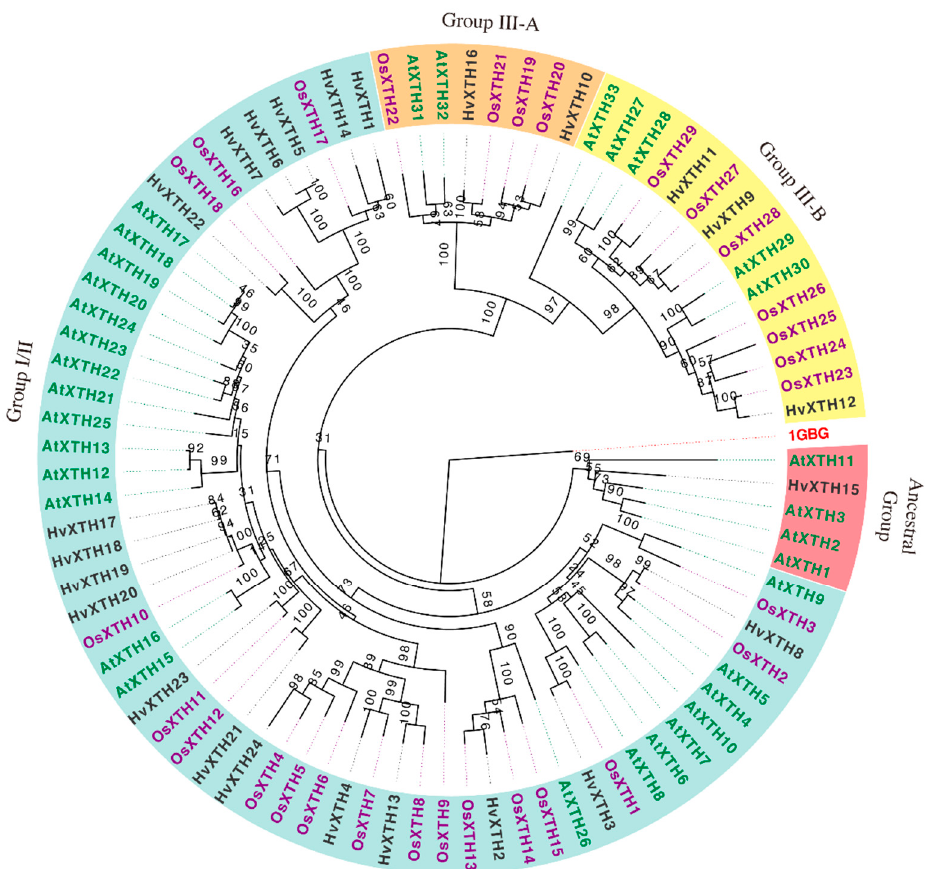
Figure 1. Phylogenetic tree of full-length HvXTH, OsXTH and AtXTH proteins . The tree was constructed using identified 24 HvXTHs in barley, 33 AtXTHs from Arabidopsis and 29 OsXTHs from rice. The numbers at each fork of the tree indicate the number of times (expressed as percentage) that the group of genes was clustered together in 100 bootstrap replicates.